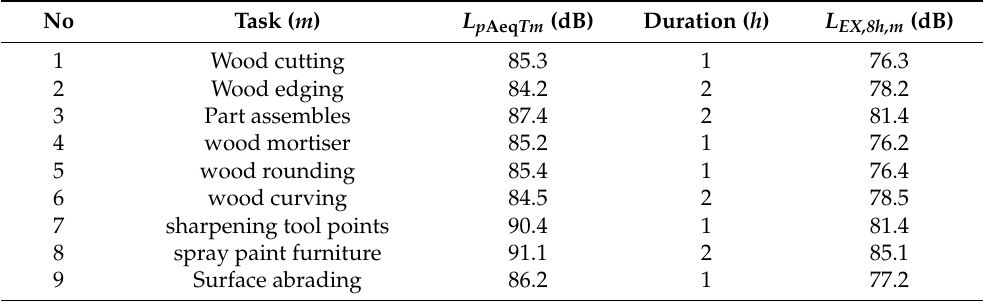
Table 3. A-weighted equivalent continuous sound pressure level and noise contribution from task m to the daily A-weighted noise exposure level results for work activities in the furniture manufacturing workshop.